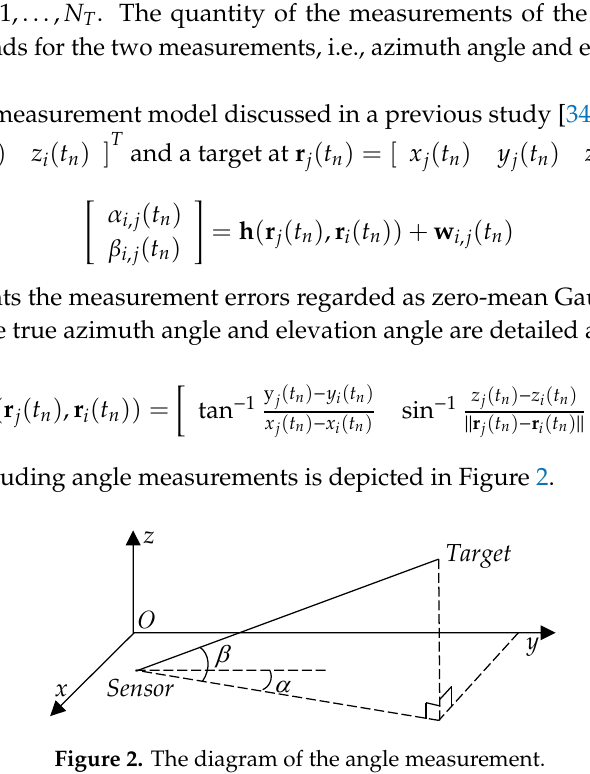
Figure 2. The diagram of the angle measurement.